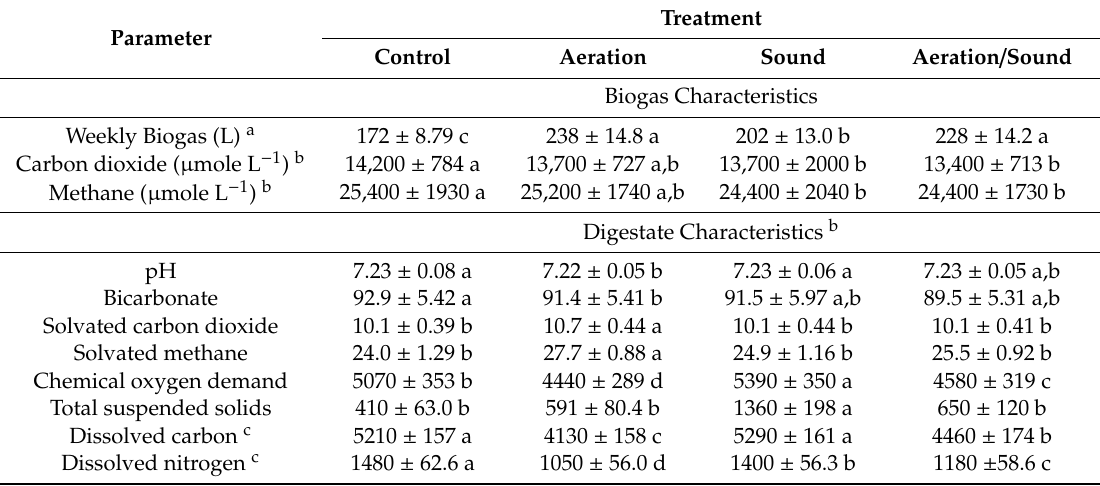
a Data represent the mean ± standard error of the mean of 61 weekly gas productions summed from daily determinations. Within a row, means labelled by the same letter are not significantly di ff erent by a Duncan’s multiple range test at p = 0.05. b Data represent the mean ± standard error of 61 weekly determinations. Within a row, means labelled by the same letter are not significantly di ff erent by a Duncan’s multiple range test at p = 0.05. c Data represent the mean ± standard error of 35 weekly determinations. Within a row, means labelled by the same letter are not significantly di ff erent by a Duncan’s multiple range test at p =